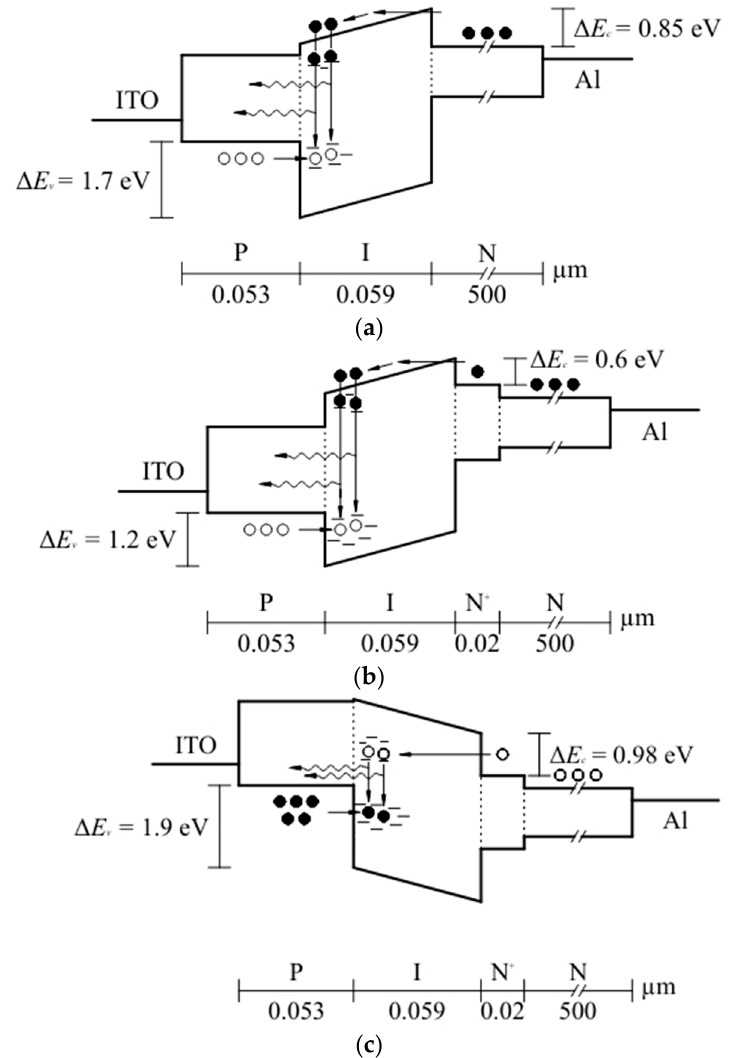
Figure 9. Energy band diagram of the devices: ( a ) PIN in FB, ( b ) PIN + N in FB, and ( c ) PIN + N in RB. Table 3. Electroluminescence properties of PIN and PIN + N